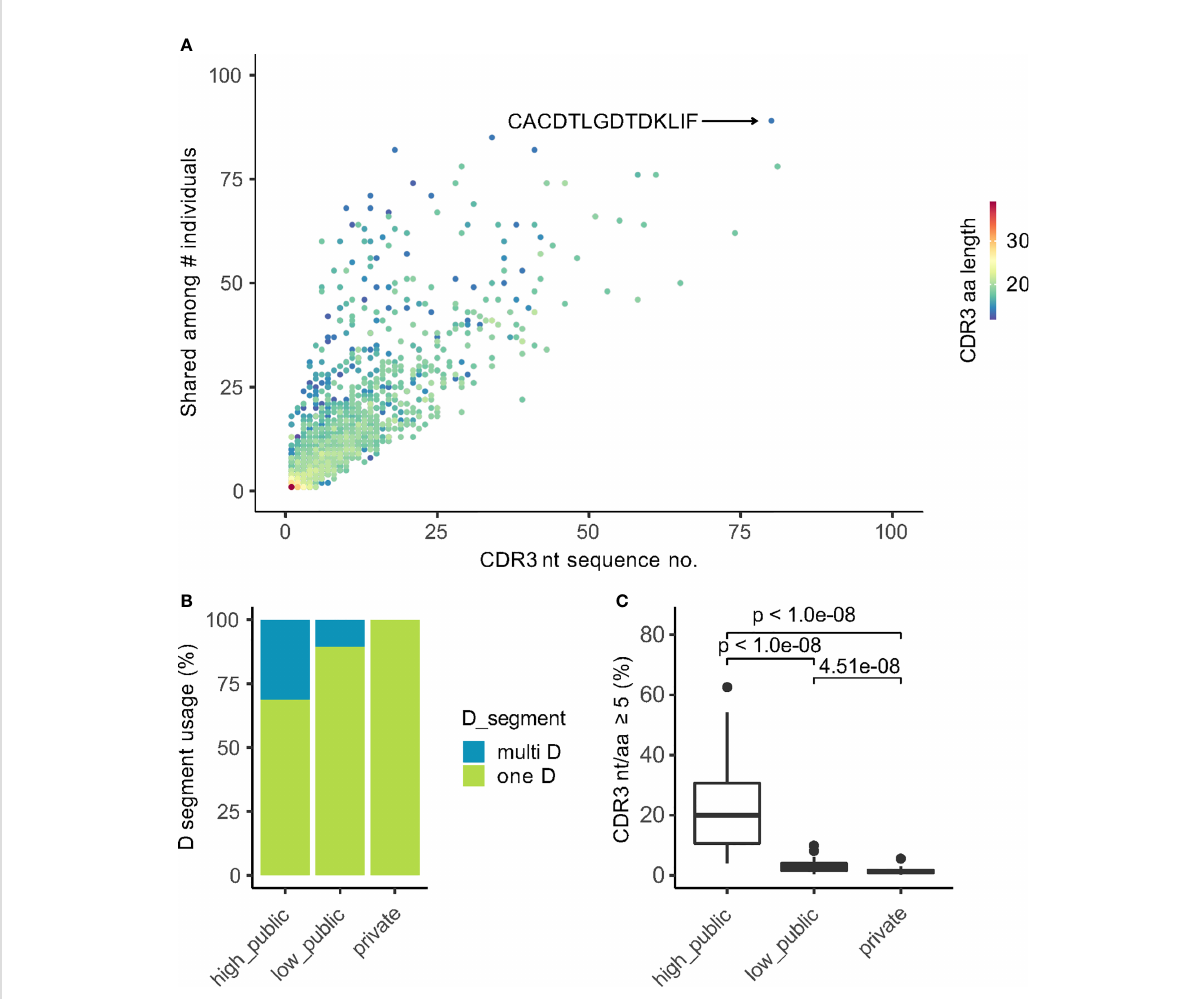
FIGURE 4 Public CDR3aa clones have more corresponding CDR3nt transcripts. (A) Scatter plot of the publicity of CDR3aa (number of individuals sharing the CDR3aa) vs the number of corresponding CDR3nt sequences. Each point indicates one unique CDR3aa sequence colored by the CDR3aa length. The most public CDR3aa sequence are indicated on the plot. (B) TRDD-segment usage of CDR3 sequences in different publicity groups. (C) Box plot shows the ratio of CDR3aa sequences translated from 5 or more different nucleotide transcripts in each individual.